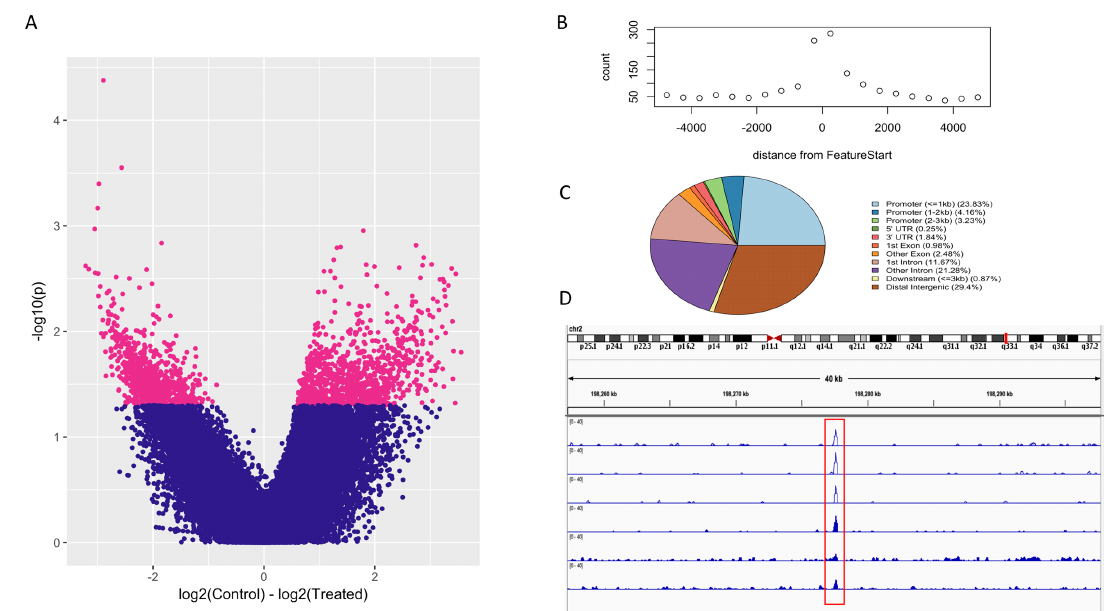
Fig 2. ATAC-seq analysis. (A) Volcano plot to show differentially accessible peaks, nominally significant peaks (p = 0.05) and shown in pink. (B) Annotation of an example peaks shows increased counts at transcription start sites. (C) Distribution of all peaks in the consensus peak set across genomic features. (D) Example track of ATAC-seq peaks, ethanol treated samples are shaded in blue.